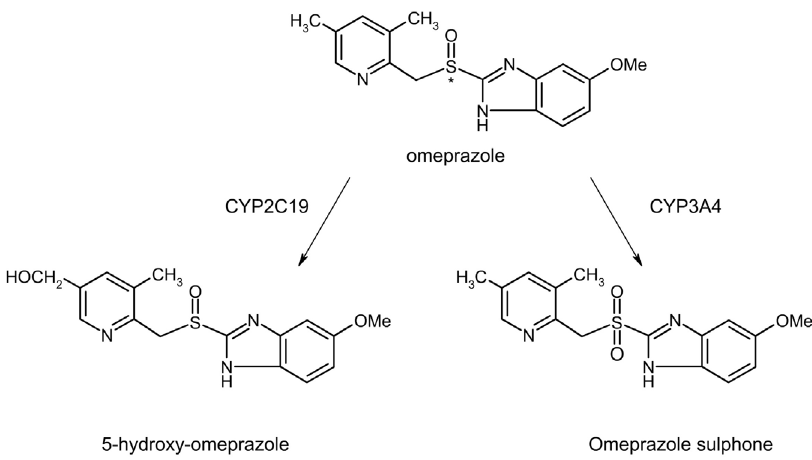
FIGURE 1 - Main metabolic routes of omeprazole. CYP2C19 catalyzes omeprazole hydroxylation forming 5-hydroxy-omeprazole, while CYP3A4 catalyzes the sulphonation reaction, leading to